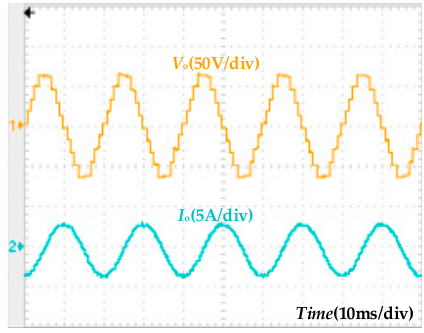
Figure 18. Output voltage and current under the L -load condition.